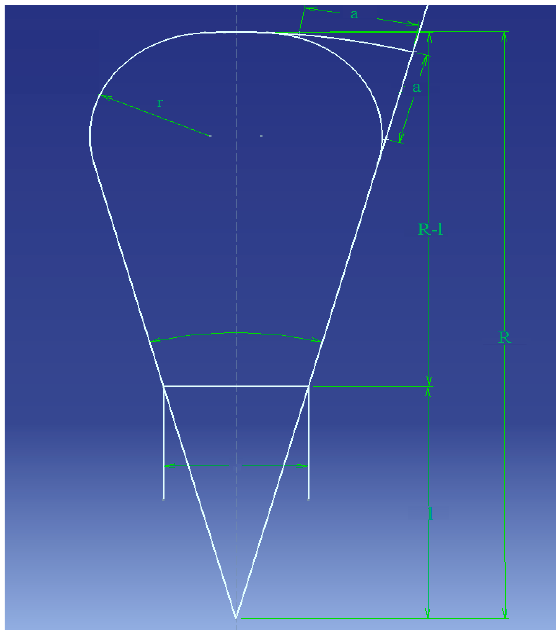
Figure 2. Internal cross-sectional area profile of designed volute casing.